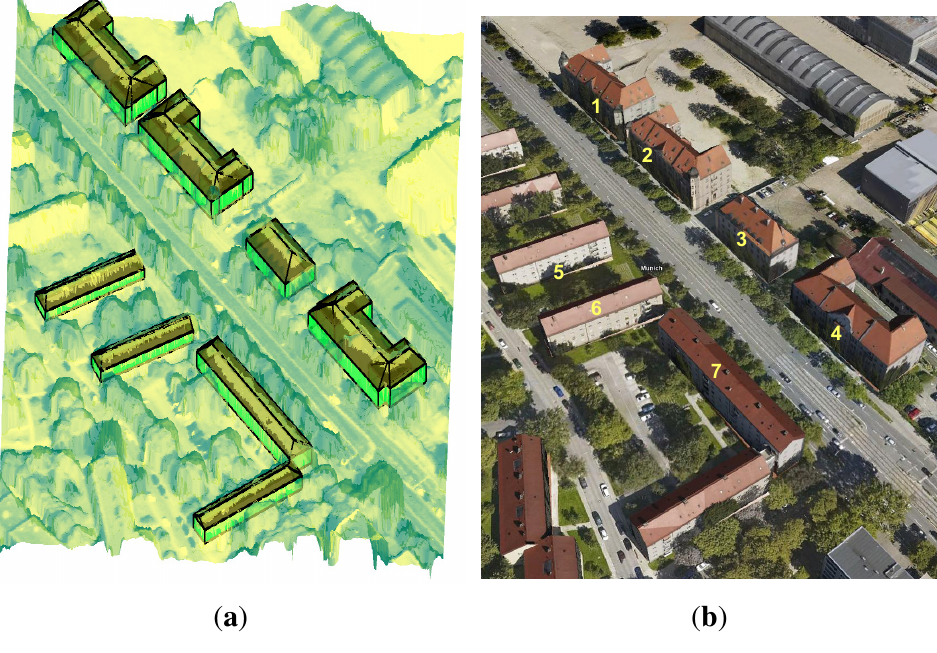
Figure 17. Final representation of ( a ) the 3D models comparing with ( b ) the Google Earth image. (a) 3D representation of parametric models superimposed on DSM texturized by orthoimage; (b) Google earth, corresponding to the test